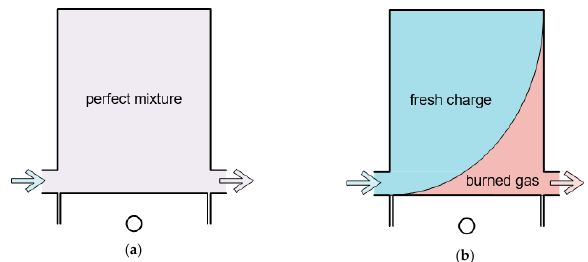
Figure 1. ( a ) Perfect mixing model; ( b ) perfect displacement model.